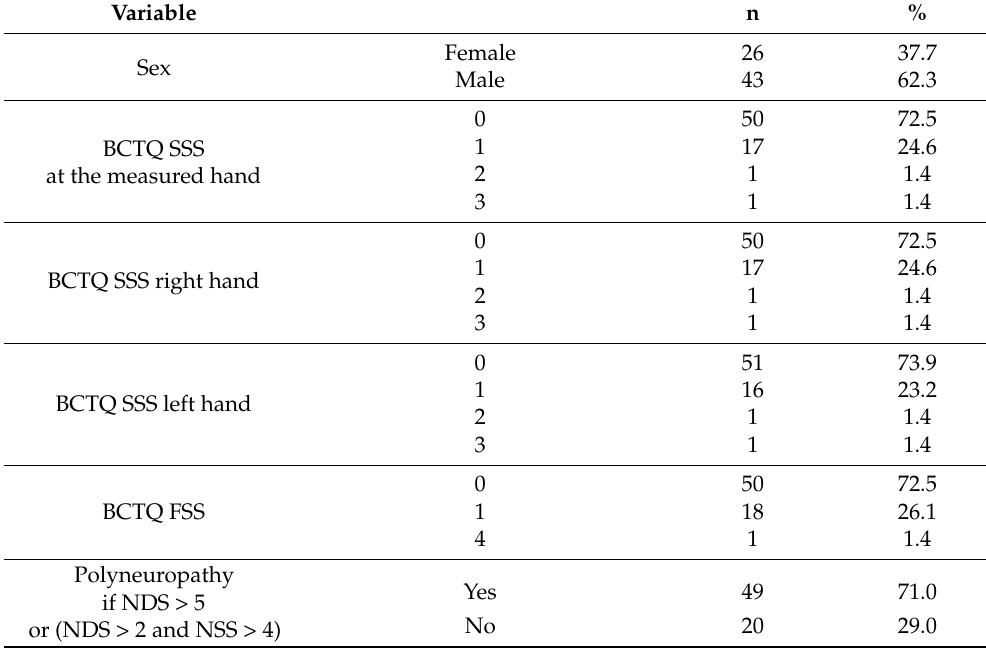
Table 1. Baseline characteristics of the patients (n = 69), categorical